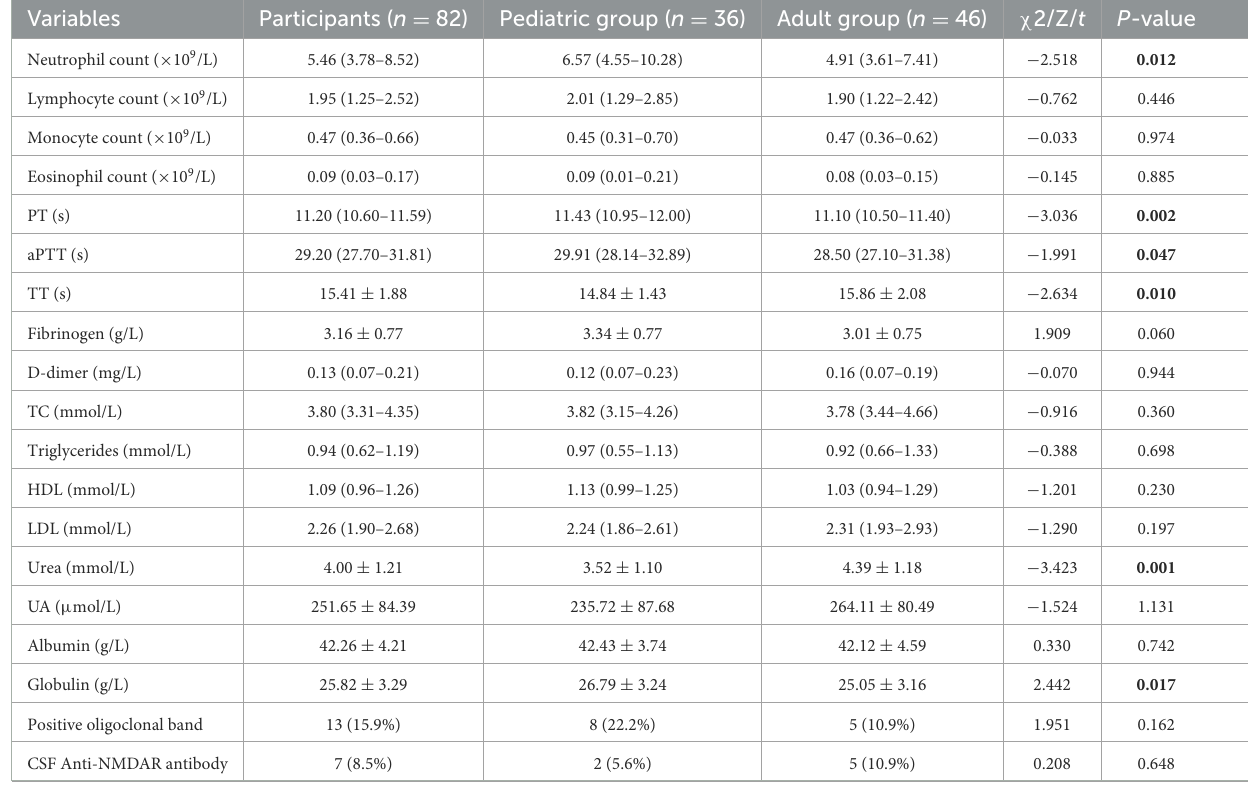
TABLE 2 Laboratory data in different age groups.